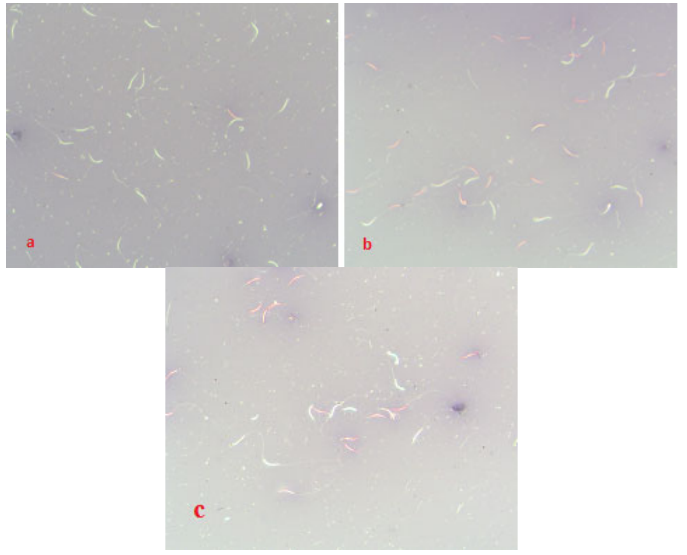
Figure 2. Evaluation of viability of spermatozoa (eosin/nigrosin) under the influence of technological factors: ( a ) native diluted semen (filtration); ( b ) frozen/thawed semen (filtration); ( c ) frozen/thawed semen (centrifugation). Classification: pink-stained spermatozoa were considered damaged (dead), white cells were considered intact (alive).